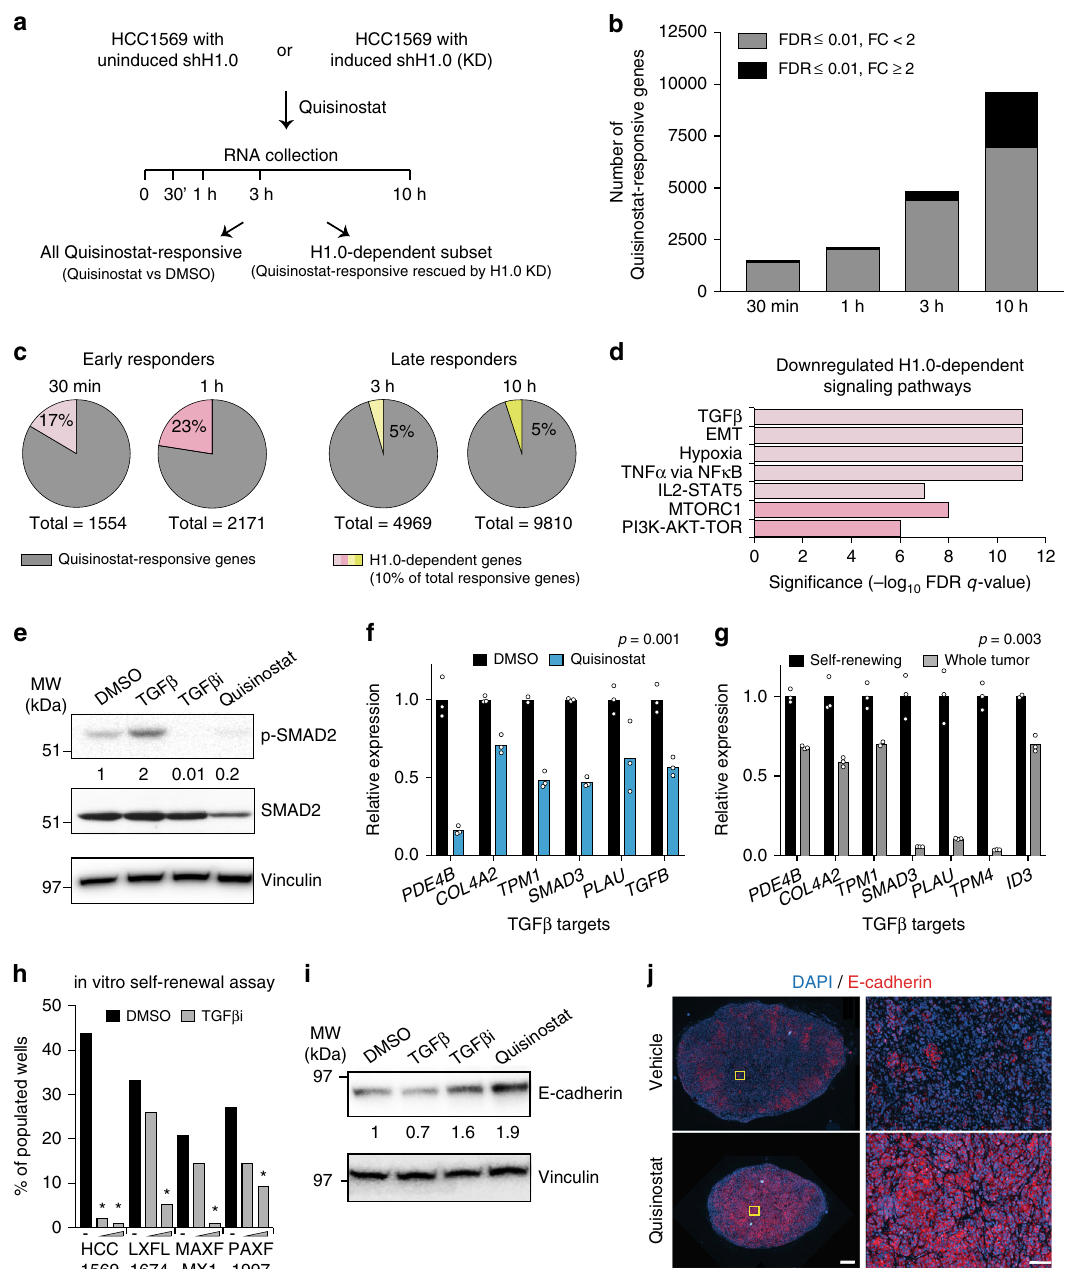
Fig. 5 A minority of Quisinostat-responsive genes are responsible for inhibiting cancer cell self-renewal. a Experimental design of the gene expression analysis. b , c Quanti fi cation of Quisinostat-responsive genes ( b ) and the subset of H1.0-dependent genes ( c ) at the indicated time points. FDR: false discovery rate. FC: fold-change. d Signaling pathways downregulated by Quisinostat treatment and rescued by H1.0 knockdown, as assessed by GSEA analysis. Gene signatures downregulated at 30 min (light pink) and at 1 h (dark pink) are shown. See also Supplementary Fig. 6c. e Quanti fi cation of total and phosphorylated SMAD2 (p-SMAD2) in HCC1569 cells by western blot analysis. Vinculin: loading control. Treatments with recombinant TGF β (TGF β ) or the TGF β inhibitor SB431542 (TGF β i) were performed as controls. Similar results were obtained in an independent experiment. f , g qRT-PCR analysis of the indicated TGF β target genes 53 in Quisinostat-treated HCC1569 cells ( f ), or in self-renewing cells isolated as spheroids from LXFL1674 PDX and the corresponding whole tumor ( g ). Values are mean from three technical replicates. The statistical signi fi cance of the overall difference, indicative of differential pathway activity, is indicated (paired two-tailed Student ’ s t -test). h Clonogenic assays measuring self-renewal ability of the indicated cells. The percentage of wells ( n = 96) populated by colonies is indicated. Black dash: DMSO; gray triangle: TGF β i. * p < 0.05 (two-way contingency table analysis and two-tailed Fisher ’ s exact test). Exact p -values in Source Data fi le. i Quanti fi cation of E-cadherin in HCC1569 cells by western blot analysis. Vinculin: loading control. Treatments with recombinant TGF β (TGF β ) or the TGF β inhibitor SB431542 (TGF β i) were performed as controls. Note the stronger effect of Quisinostat compared to TGF β i suggesting that additional signaling pathways promoting EMT are affected by Quisinostat. Similar results were obtained in an independent experiment. j Immuno fl uorescence microscopy of HCC1569-induced tumors treated with Quisinostat and control tumors (vehicle) detecting E-cadherin (red). Panels on the right are enlargements of the area marked in yellow on the left. Similar results were obtained in three tumors per condition and in the three PDXs. Scale bar: 500 µ m left panels, 100 µ m right panels. Data for all graphs are in Source Data fi